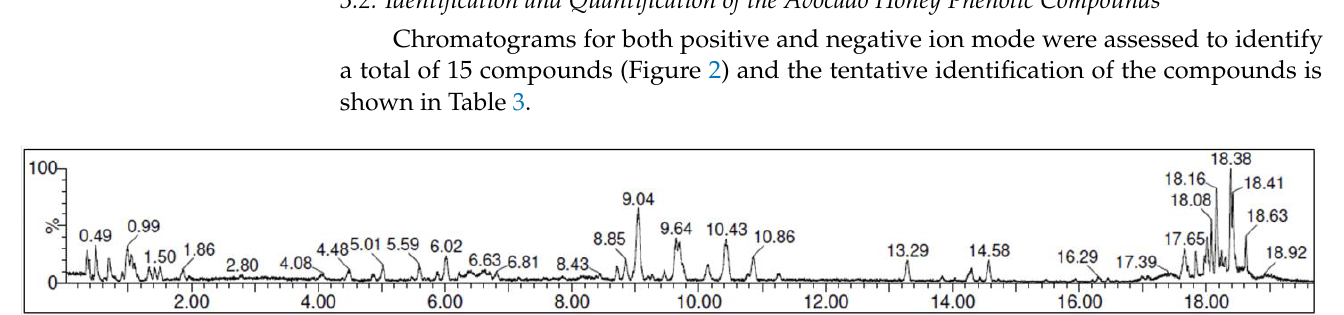
Figure 1. Representative picture of Persea spp. pollen (white arrows) under light microscope (40×).